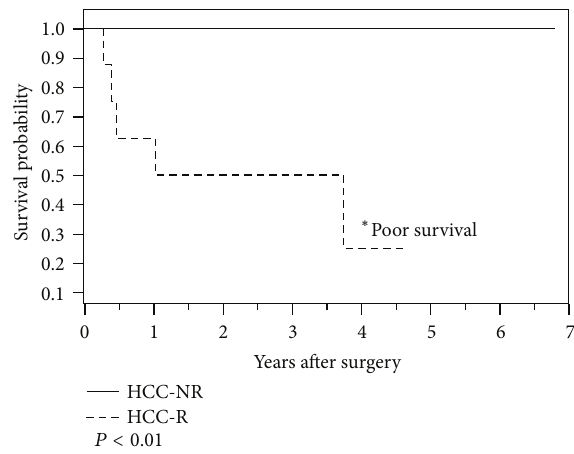
Figure 1: Kaplan-Meier survival curves comparing the high mortal- ity rate in the tumor recurrence group with the mortality rate in the nonrecurrence